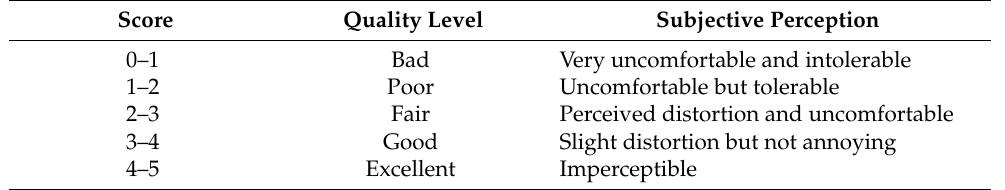
Table 7. Sound quality scoring